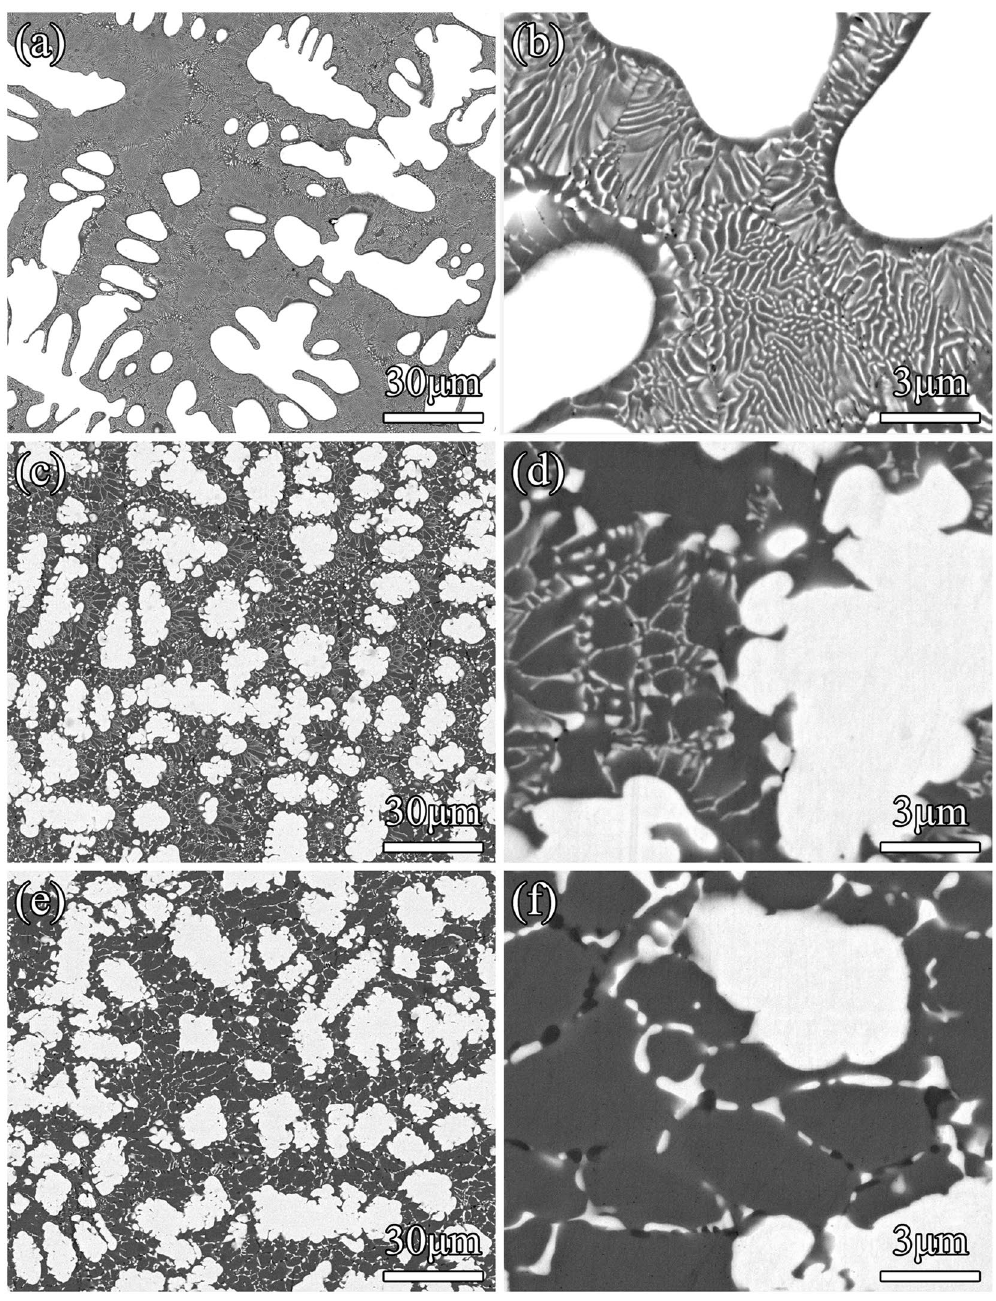
Figure 2. Back-scattered electron (BSE) micrographs of as-cast Nb 40 Ti 30 Ni 30 ( a ), Nb 35 Mo 5 Ti 30 Ni 30 ( c ) and Nb 30 Mo 10 Ti 30 Ni 30 ( e ). ( b , d and f ) Show the magnified eutectic morphology in ( a , c and e ),